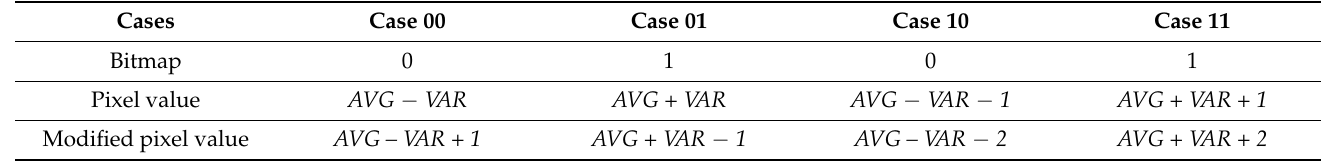
Table 2. Four hiding strategies for the second